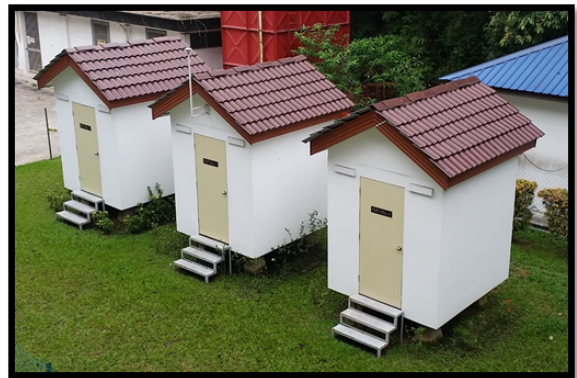
Figure 6: Picture of test huts